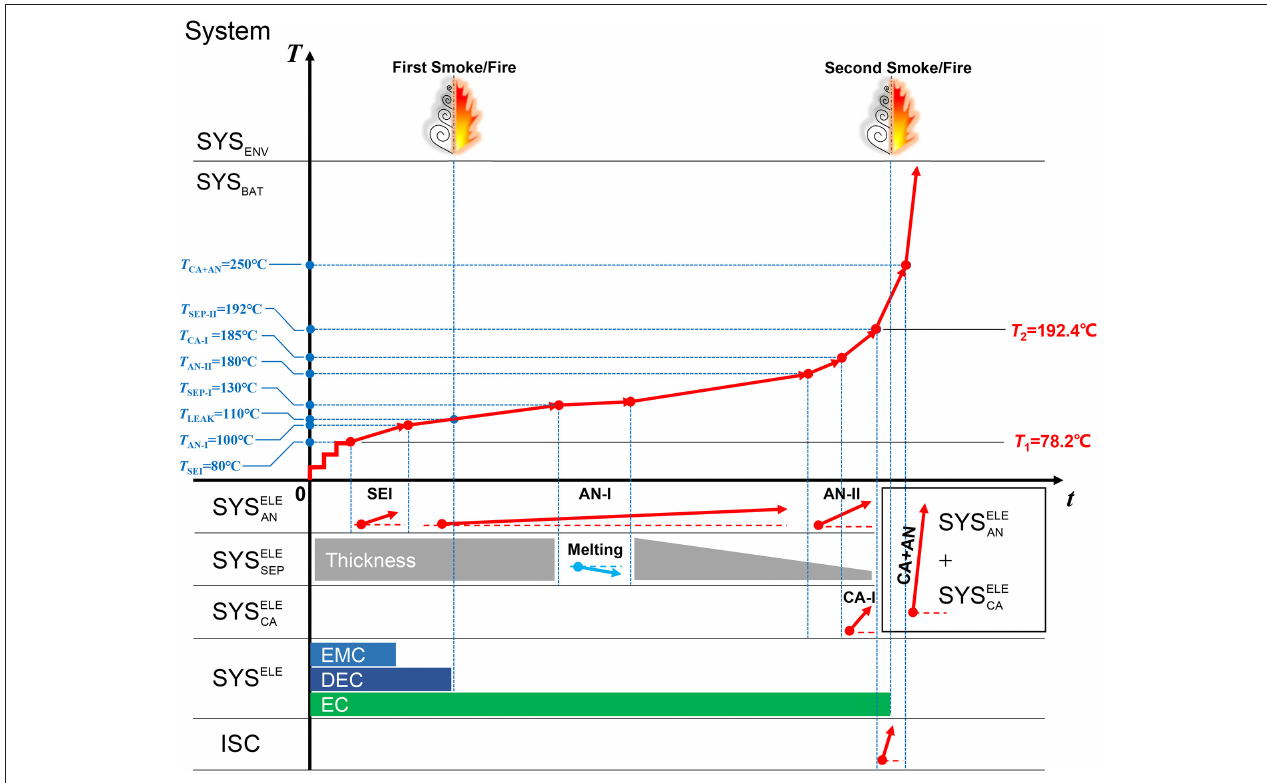
FIGURE 3 | The time sequence map for interpreting the thermal runaway mechanism of the Battery Sample